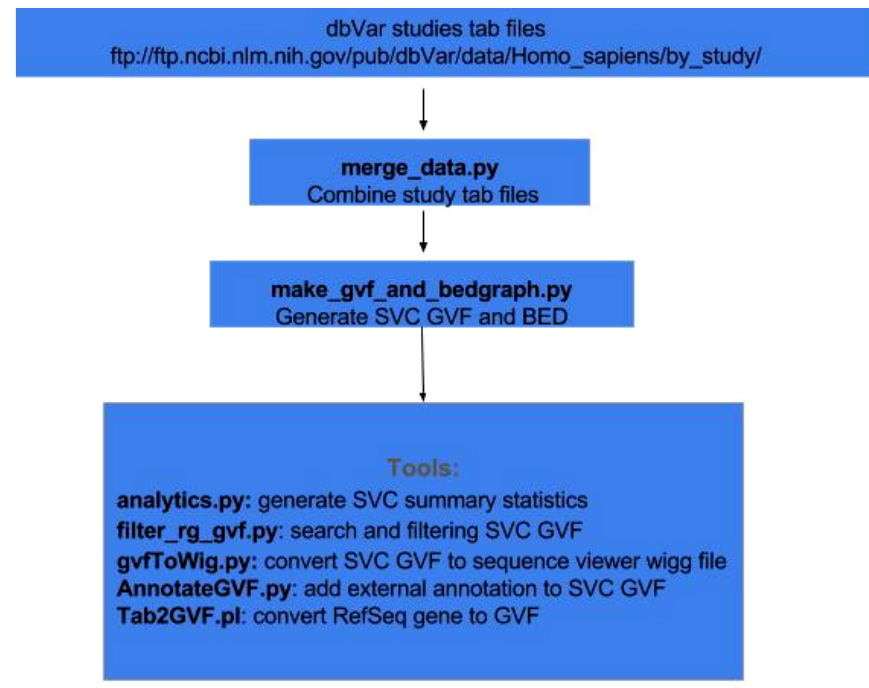
Figure 2. Dataflow for generating SVC and tools for